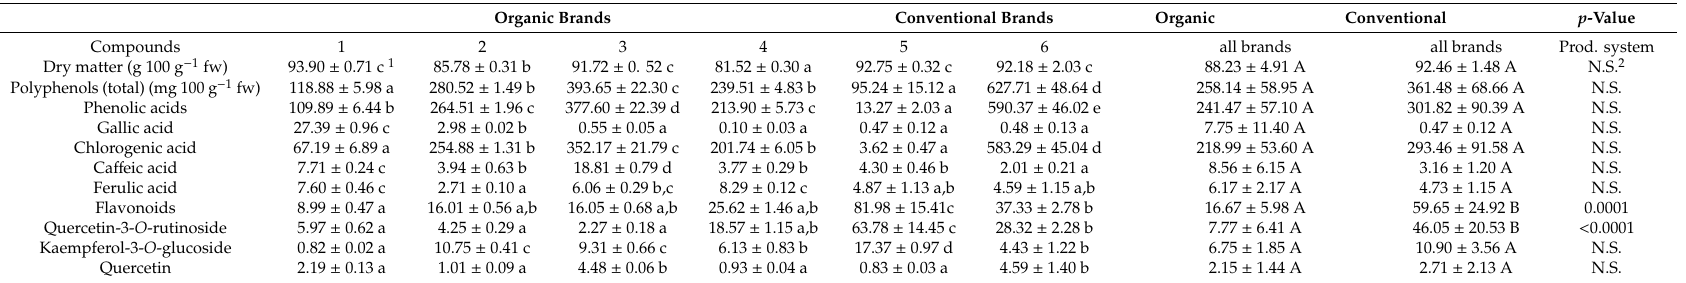
Table 2. The content of dry matter and phenolic compounds in dry apple rings of selected organic and conventional brands. Organic Brands Conventional Brands Organic Conventional p -Value